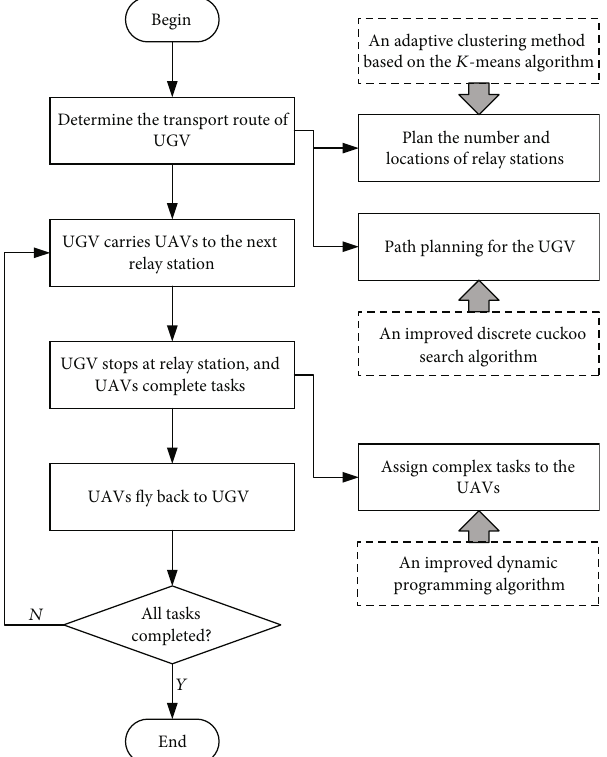
Figure 2: Flow diagram of the cooperative control process for hybrid UAV/UGV system based on the proposed